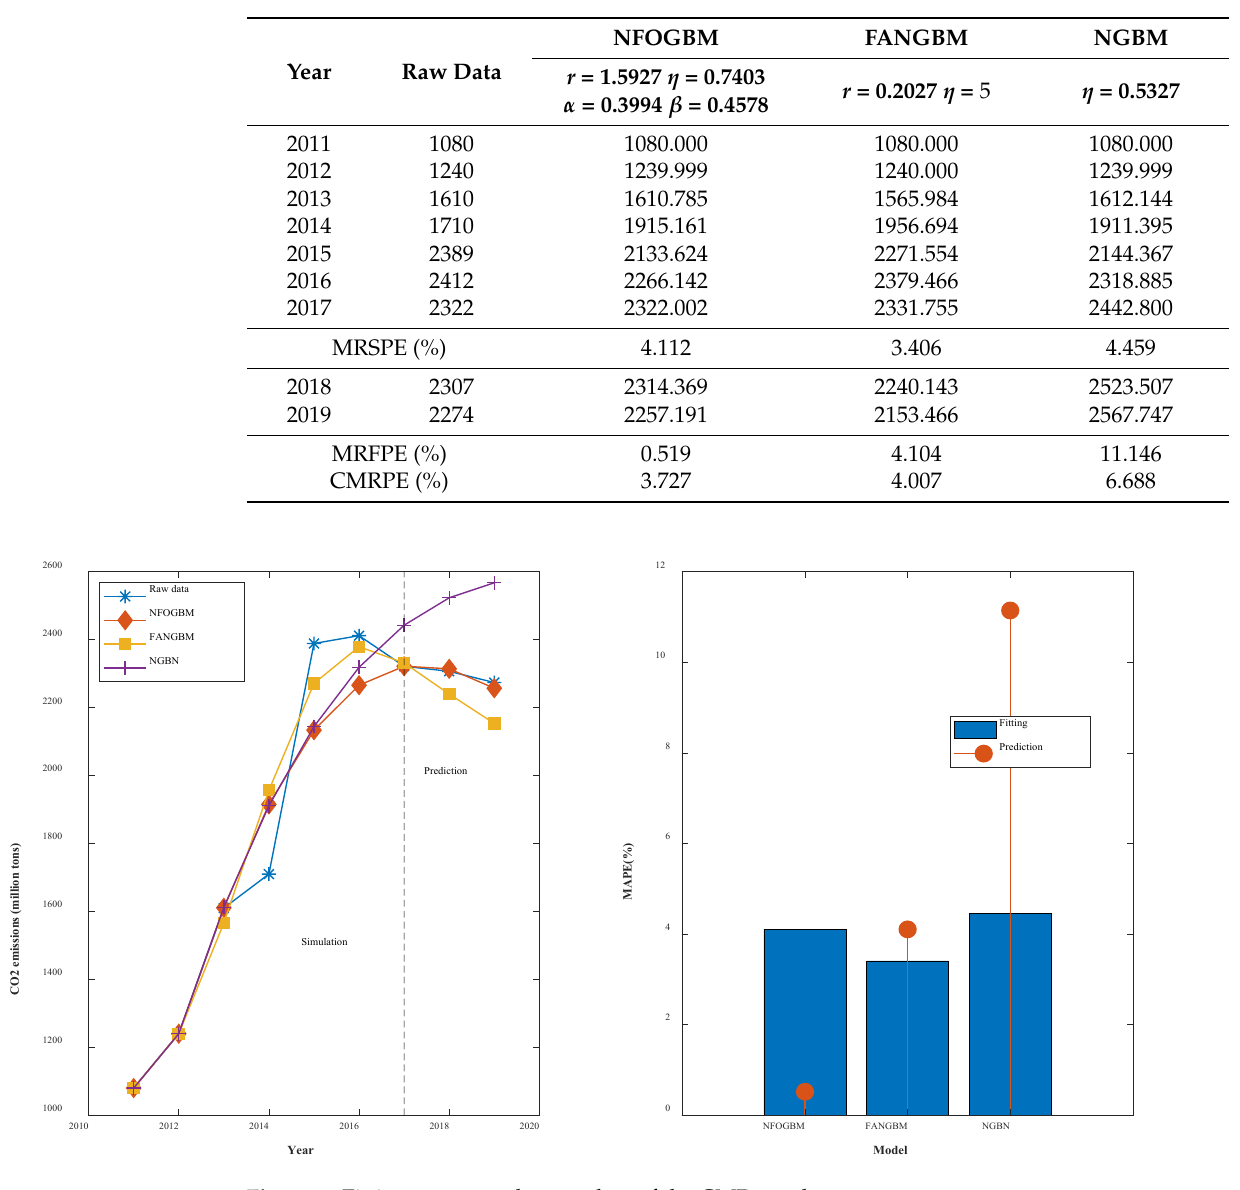
Figure 8. Fitting curves and error plots of the CMD results. (7) The modeling results for PSESH are shown in Table 8, and the fitting and error plots are shown in Figure 9. The MRPESs (%) of the NFOGBM, FANGBM, and NGBM are 0.64, 0.708, and 0.806, respectively; the MRFPEs (%) are 0.373, 0.485, and 3.172, respectively, and the CMRPEs (%) are 0.573, 0.652, and 1.397, respectively. For the NFOGBM and FANGBM, all three errors are less than 1%, which indicates that these two models perform well for this example. Although the NGBM yields improved simulations in this case compared to those in previous examples, its prediction accuracy is low. Moreover, the NFOGBM yields the lowest simulation, prediction, and synthesis errors, and the highest modeling accuracy, achieving a notable improvement over the traditional grey Bernoulli